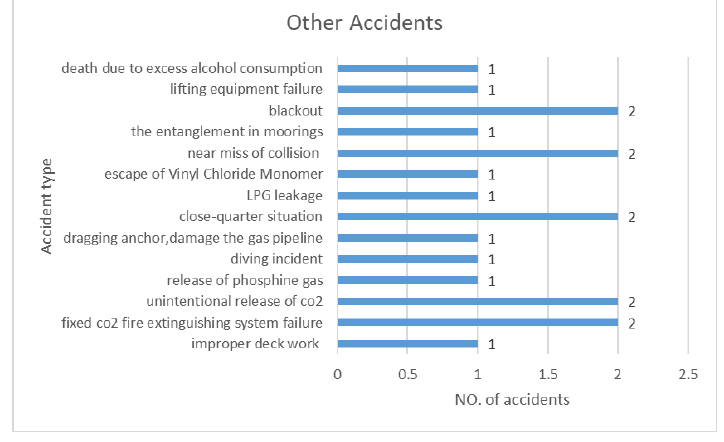
Figure 5. Other accidents.